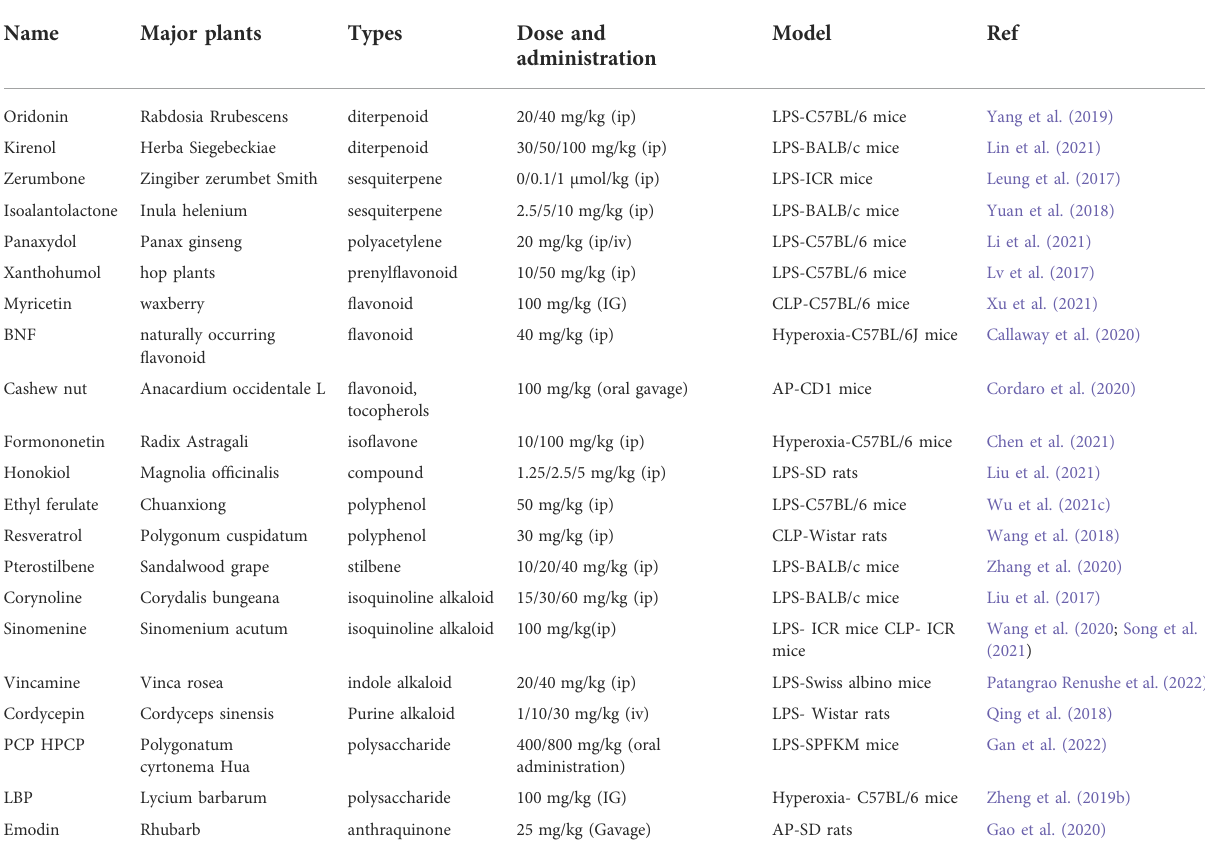
TABLE 1 Natural medicines reduce ALI with Nrf2 as the core